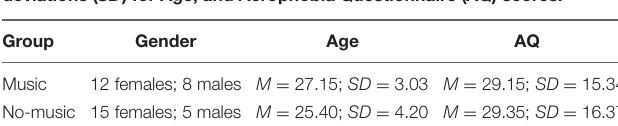
deviations ( SD ) for Age, and Acrophobia Questionnaire (AQ)